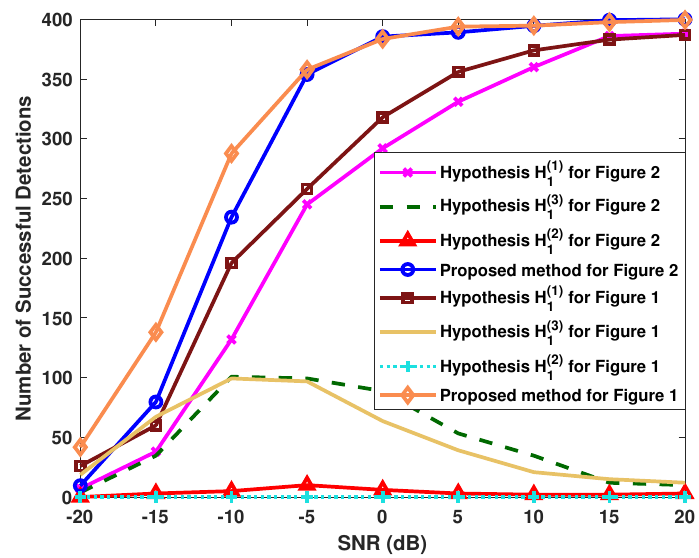
Figure 10. Comparison of the contributions of different hypotheses.